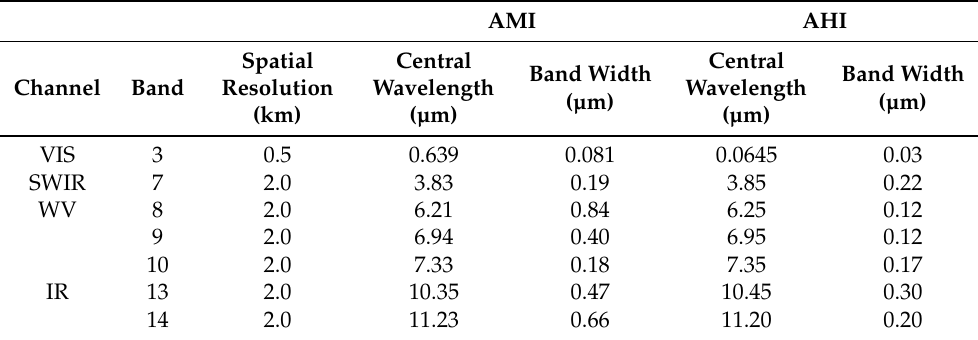
Table 1. Comparison between characteristics of the GK2A AMI and H-8 AHI used to derive AMV